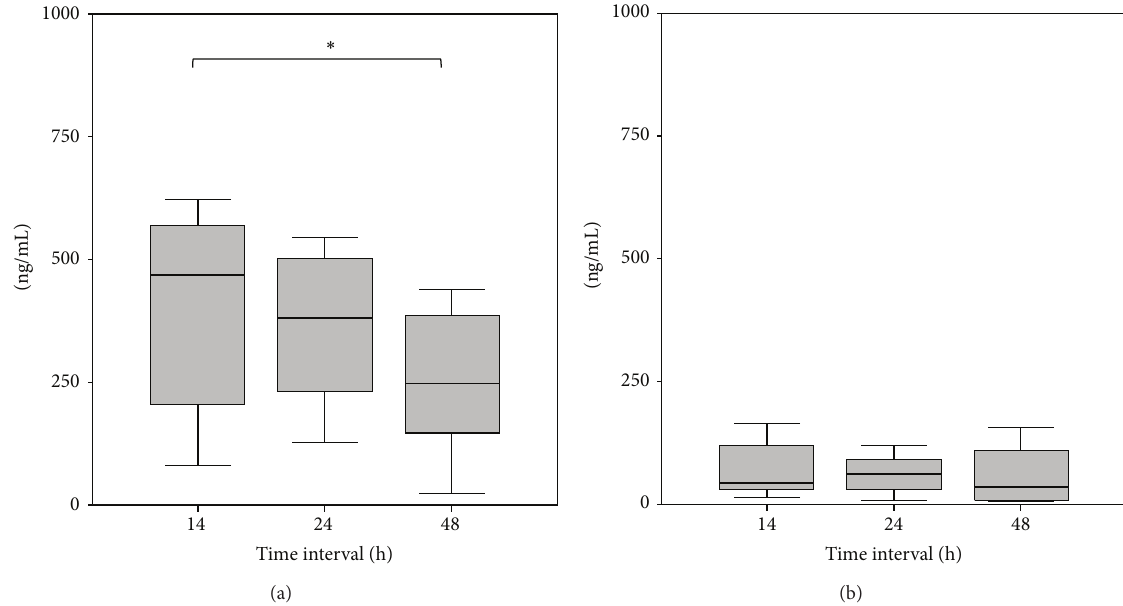
Figure 4: (a) Decreasing fracture hematoma concentrations of HMBG1, ∗ = 𝑃 < 0.05 between 14 h and 48 h. (b) Stable fracture hematoma concentrations of HSP70, ∗ = 𝑃 < 0.05 between 14h and 48